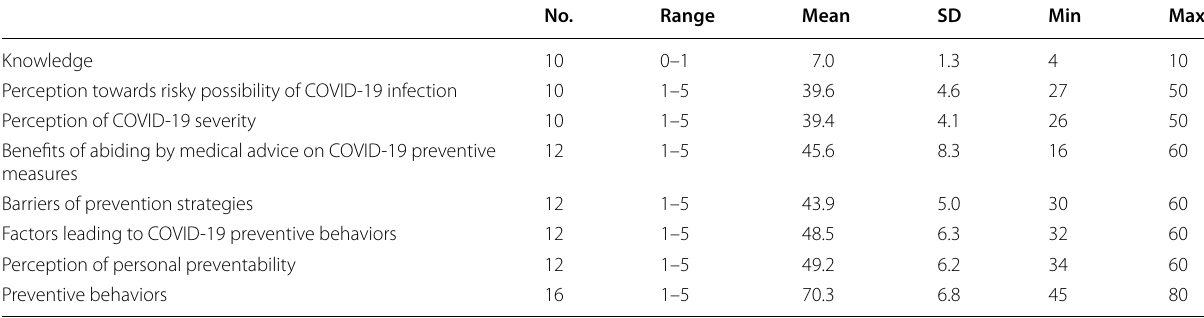
Table 3 Frequency distribution of mean, standard deviation and standardized mean of health belief model constructs for preventive behaviors of COVID-19 infection in healthcare workers